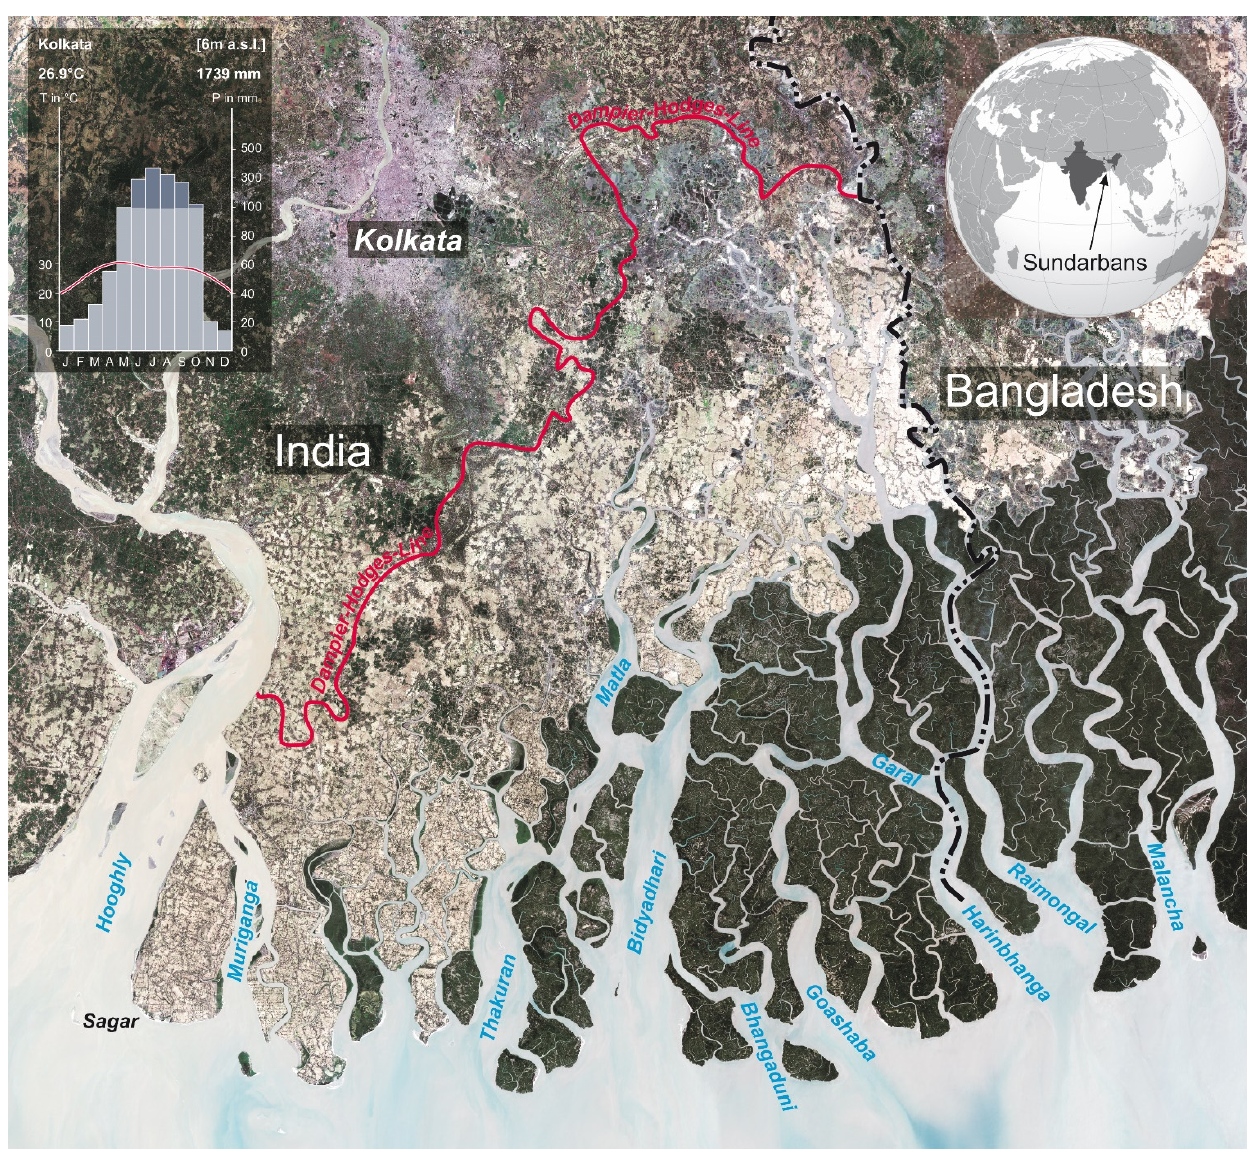
Figure 1. Overview of the Indian Sundarbans. The mangrove forests appear dark green, the surrounding agricultural land is yellowish brown. Settlements appear purple. The Dampier-Hodges-Line marks the boundary of tidal influence and roughly marks the former extent of mangrove forests. Insets show location of the Sundarbans and a climatic diagram of Kolkata representing the climatic conditions of the